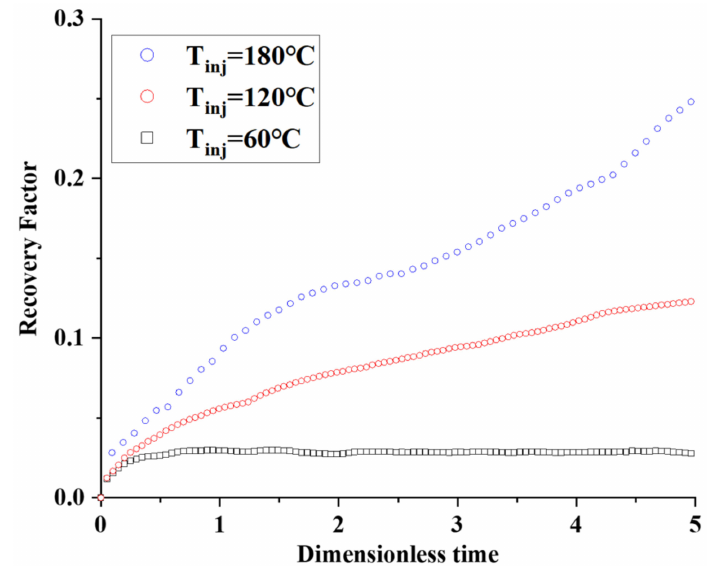
Figure 27. Recovery factor change with different injection